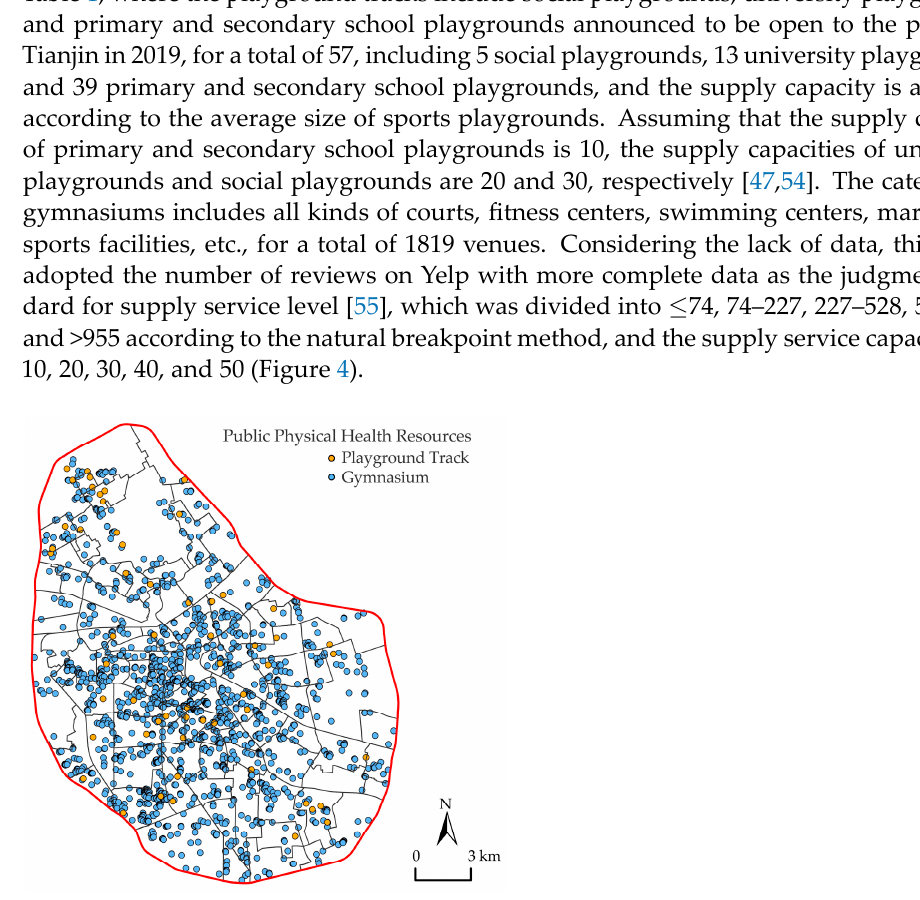
Figure 3. Spatial distribution of public natural health resources in the research area.